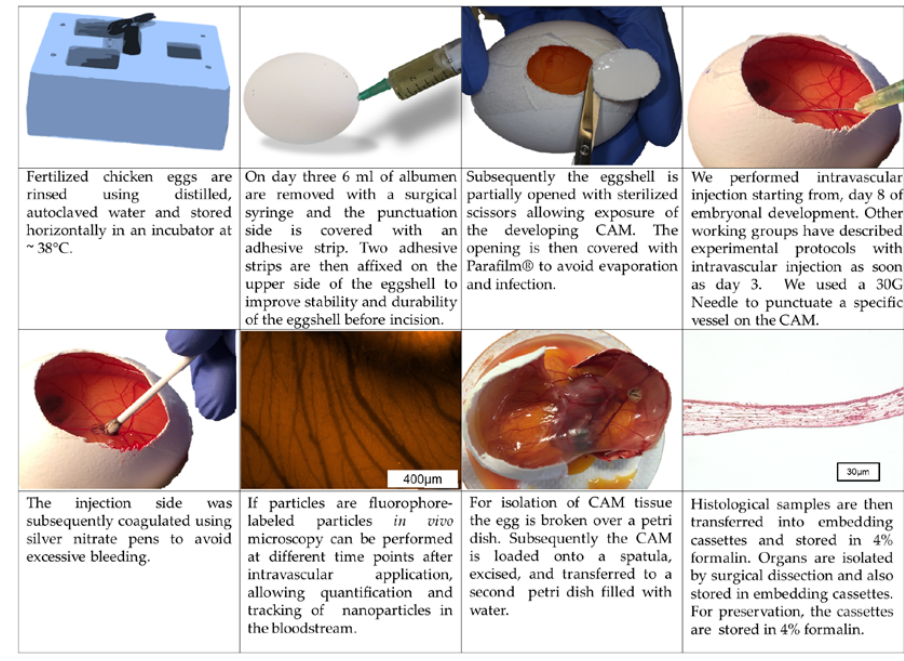
Figure 3. Technique of the CAM assay ( in ovo model) as established in our laboratory.